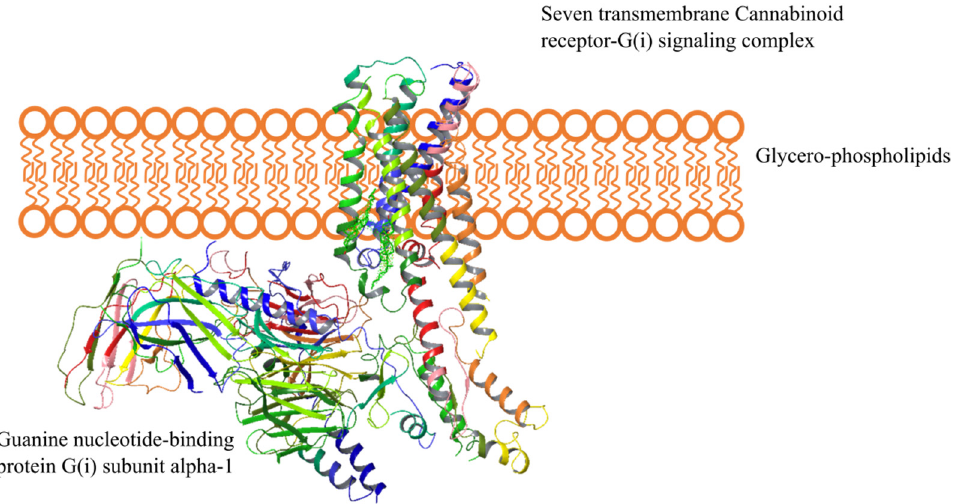
Figure 2. Helical representation of the CB1 receptor. The seven-transmembrane receptor is embedded into the cell membrane, having extracellular helices extending into the extracellular environment and the intracellular helices protruding into the intracellular environment where it interacts with the Guanine nucleotide-binding protein G( i ) subunit alpha-1. The extracellular domain has an N-terminal that possesses glycosylation sites, while the intracellular domain has a C-terminal coupled to a G-protein complex. Adapted from reference [26]. Modified using Schrödinger Release Software 2021-4: Maestro, Schrödinger, LLC, New York, NY, 2021.